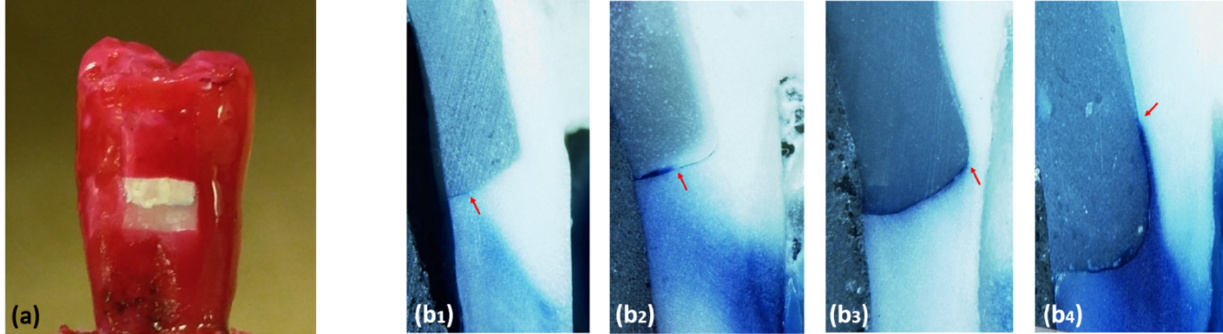
Figure 2. Varnish used to coat all tooth surfaces except 1mm around the gingival margin ( a ). Samples of specimens with different microleakage scores, scores 1, score 2, score 3, score 4 (( b1 – b4 ) respectively).